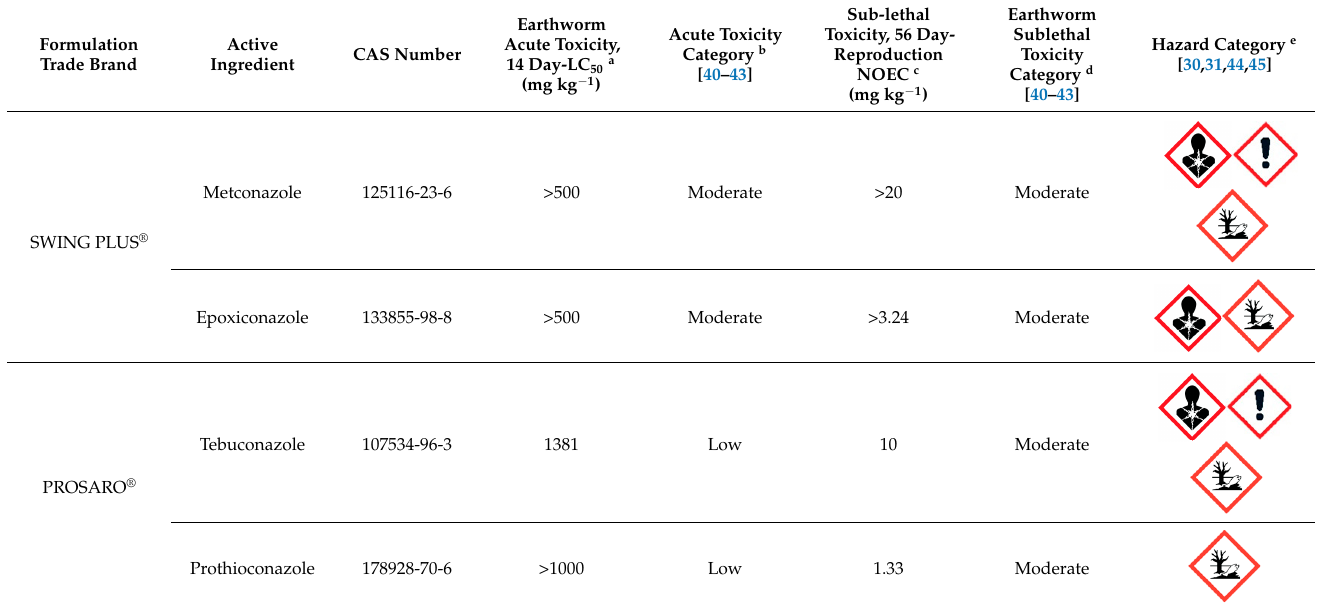
Table 4. The hazards of other ingredients declared in two commercial fungicide formulations.